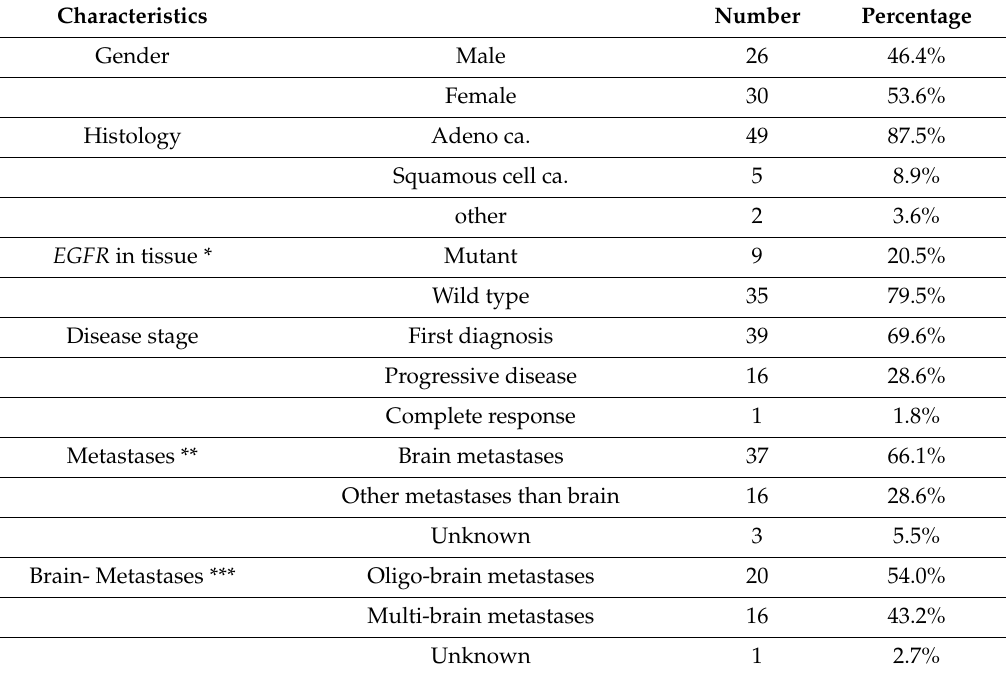
Table 1. Clinical characteristics of non-small cell lung cancer (NSCLC) patients’